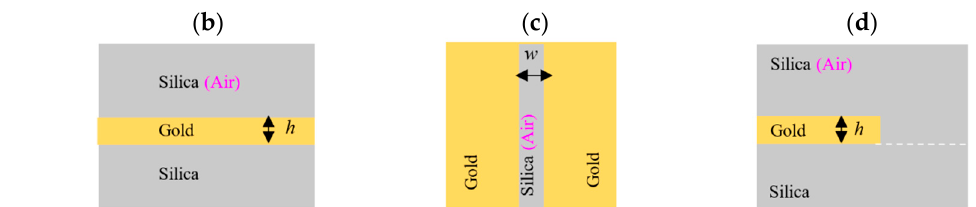
Figure 1. Cross-section view of ( a ) a gold-based plasmonic slot waveguide (PSWG), ( b ) a dielectric- metal-dielectric (DMD) structure, ( c ) a metal-dielectric-metal (MDM) structure, ( d ) a truncated metal film (TMF) structure. In the plasmonic slot waveguide, DMD, and TMF structures, when the gold layer is surrounded by silica, structures are referred to as symmetric structures. In contrast, when air is the upper cladding and silica is the substrate, structures are referred to as asymmetric structures. The white dashed line in Figure ( d ) indicates the interface between air and silica regions when we consider an asymmetric structure.